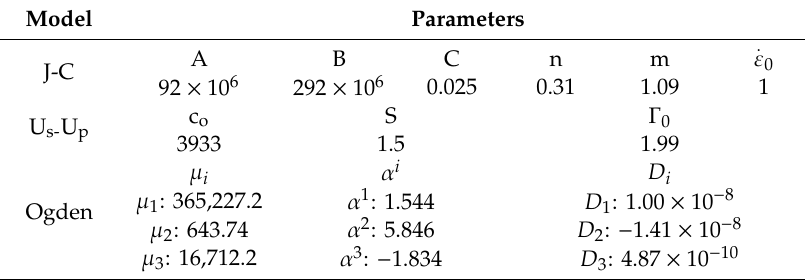
Figure 3. ( a ) Incident, transmitter, specimen mesh selection. and ( b ) Pulse shaper mesh. Table 1. Johnson-Cook and Equation of State input parameters for pulse shaper and Ogden parameters for specimen.